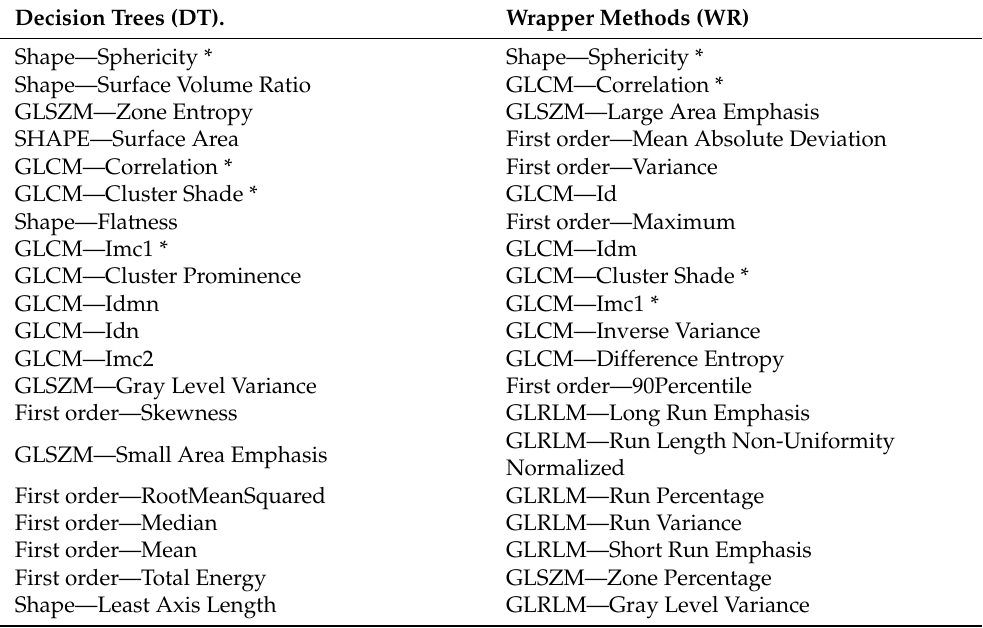
Table 3. Top 20 radiomic features, in ascending order of priority, used in the ML models as generated from the Decision Tree (DT) classification, and Wrapper method (WR). Features with asterisk(*) were common in both DT and WR features.